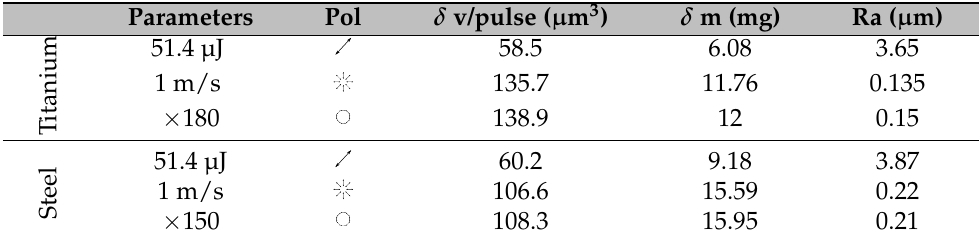
Table 1. Ablation efficiency (volume ablated per pulse); mass removal and Ra for titanium and stainless steel at same